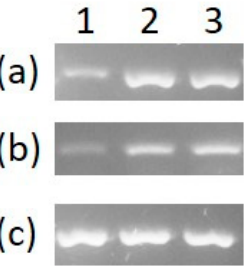
Figure 6. Expression of the S. maltophilia 02 copper translocating P-type ATPase gene and cueR . During exponential growth, S. maltophilia 02 was exposed to 1 mM CuSO 4 , 200 µ M HAuCl 4 · 3H 2 O or no metal in three separate cultures. One hour after exposure, total RNA was purified from each culture and converted to cDNA using reverse transcriptase. The cDNA was then PCR amplified using primers specific for the copper P-type ATPase translocation gene, the cueR gene and the glyceraldehyde-3-phosphate dehydrogenase (GAPDH) gene. The PCR reactions were separated using a 2% agarose gel. ( a ) The copper P-type ATPase translocation gene, ( b ) cueR and ( c ) GAPDH. (Lane 1) no metal, (Lane 2) copper and (Lane 3) gold. The more intense bands for copper and gold suggest that expression of the ATPase and cueR genes increases in response to copper and gold.